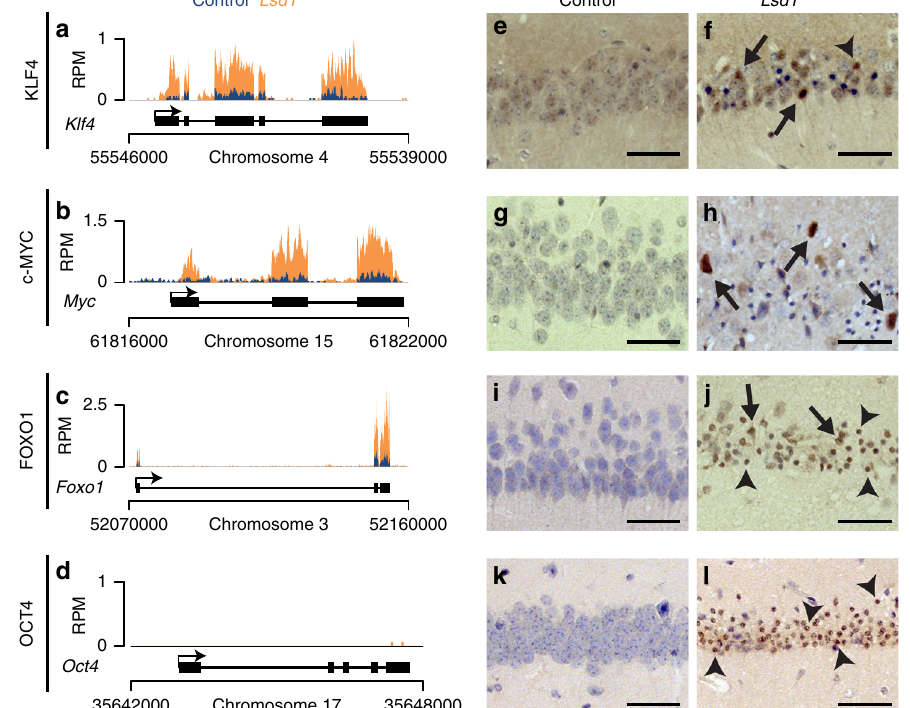
Fig. 3 Ectopic activation of stem cell genes in Lsd1 CAGG mice. a – d Genome browser style plot of RNA-seq reads per million (RPM) from control (blue) and overlaid Lsd1 CAGG (orange) hippocampi showing expression of the genes Klf4 a , Myc b , Foxo1 c , Oct4 d . e – l Immunohistochemistry (IHC) with antibodies to KLF4 e , f , c-MYC g , h , FOXO1 i , j , and OCT4 k , l in control e , g , i , k and Lsd1 CAGG f , h , j , l CA1 neuronal nuclei. Arrows denote non-pyknotic nuclei and arrowheads denote pyknotic nuclei. All IHC is counterstained with hematoxylin. All Lsd1 CAGG images are taken at the terminal phenotype.